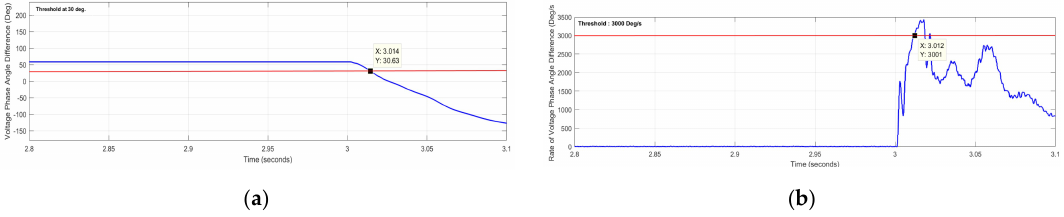
Figure 15. Results of case (vii) Effect of Multiple DGs on the Islanded Grid. ( a ) Voltage phase angle difference; ( b ) Rate of change of voltage phase angle difference.